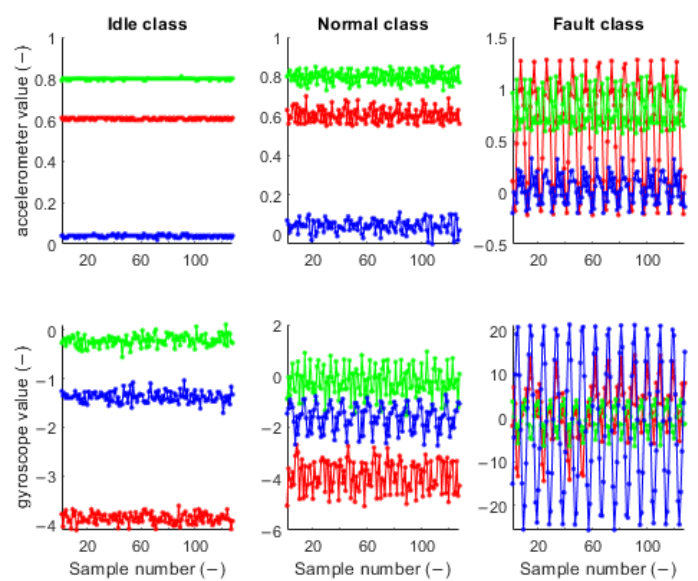
Figure 11. Accelerometer and gyroscope time domain data in 3-axis: red— X , green— Y , and blue— Z .